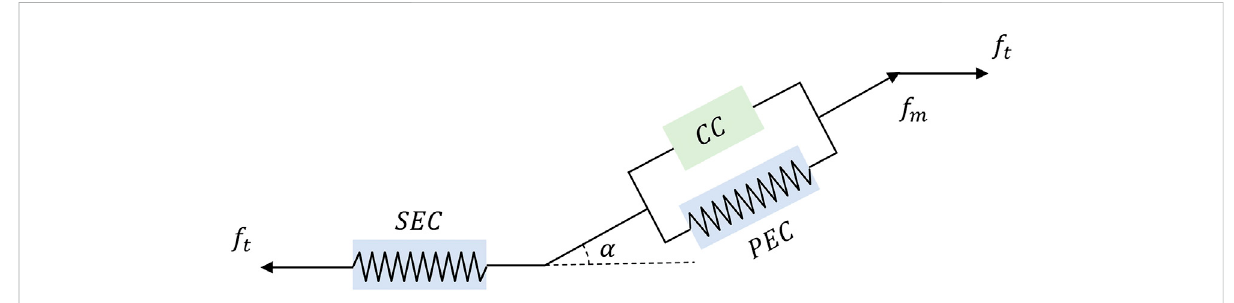
FIGURE 4 A diagram of Hill-based muscle model includes CC, PEC, and SEC, where f t and f m represents the muscle tendon force and muscle fi ber force. And α is the pennation angle, which is de fi ned as the angle between the direction of muscle fi bers and the line of action of the muscle force.